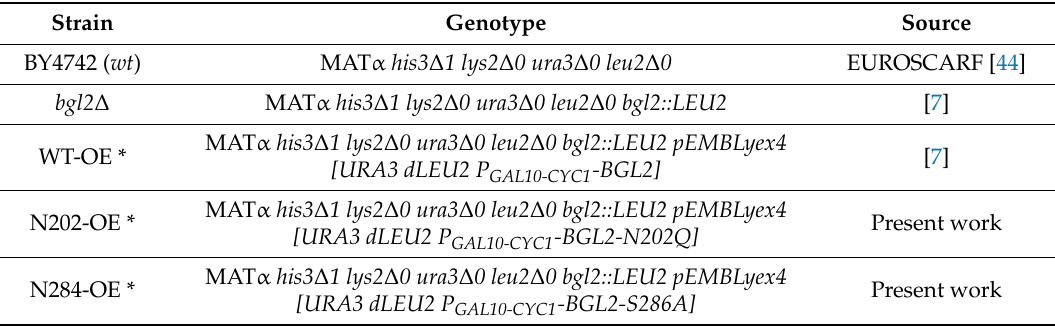
Table 3. Saccharomyces cerevisiae strains used in present